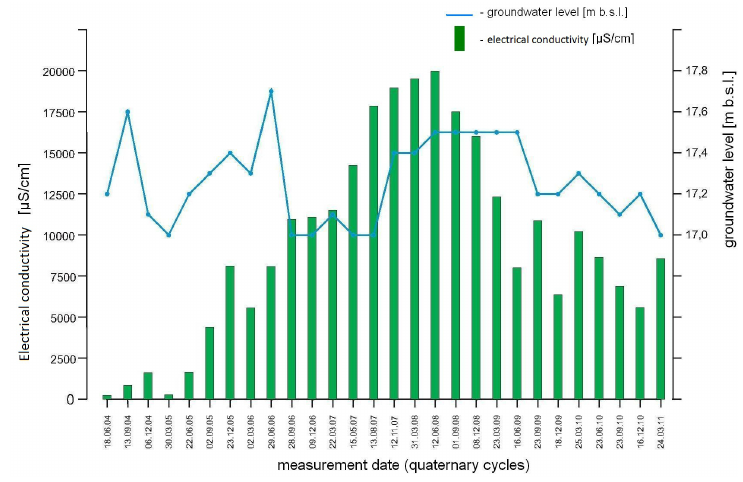
Figure 2. Electrical conductivity (EC) and ground water table changes over